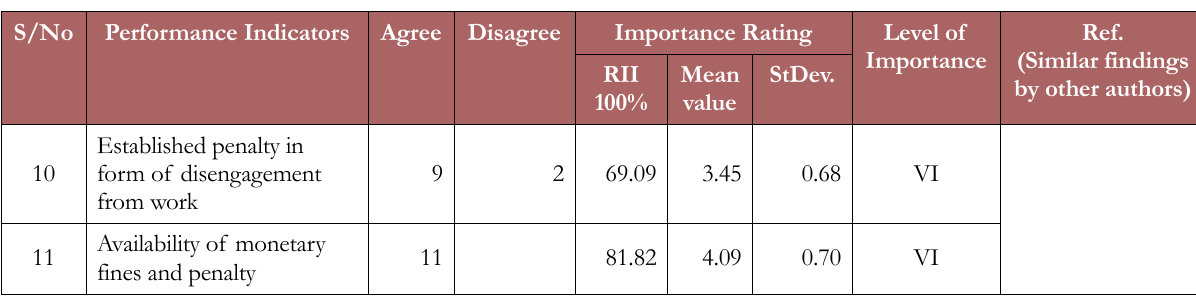
Table 10. Key Performance Indicators for Rewards and Sanctions for project